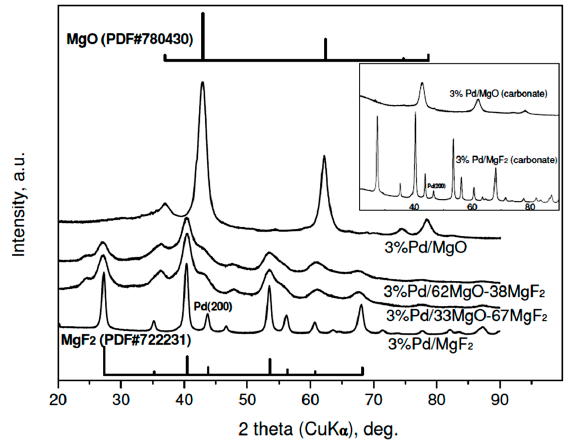
Figure 1. XRD profiles of reduced 3 wt % Pd/MgO-MgF 2 catalysts (“sol-gel” series). Reflections for MgF 2 and MgO are presented by bars proportional to their relative intensities. Inset: diffractograms of 3 wt % Pd catalysts of the “carbonate” series. To simplify the notation the composition of MgO-MgF 2 mixture the % symbol is usually dropped in further text.